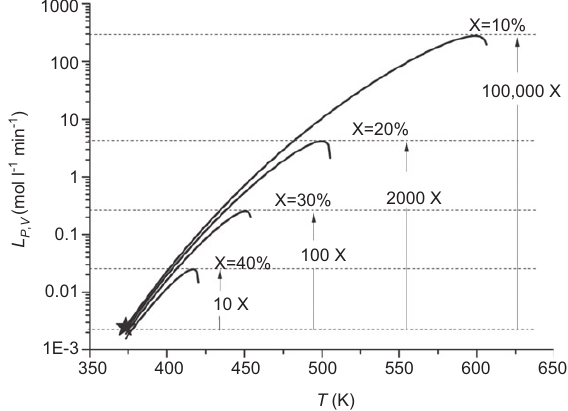
Figure 5 Specific performance L as a function of the temperature p,v representative for the determination of the optimal novel process = 0.4 m , C = 1.2 m for different equilib- window at P = 10 bar, C 1,0 KHCO 3 ,0 rium conversions. The conventional batch process is represented by the star.